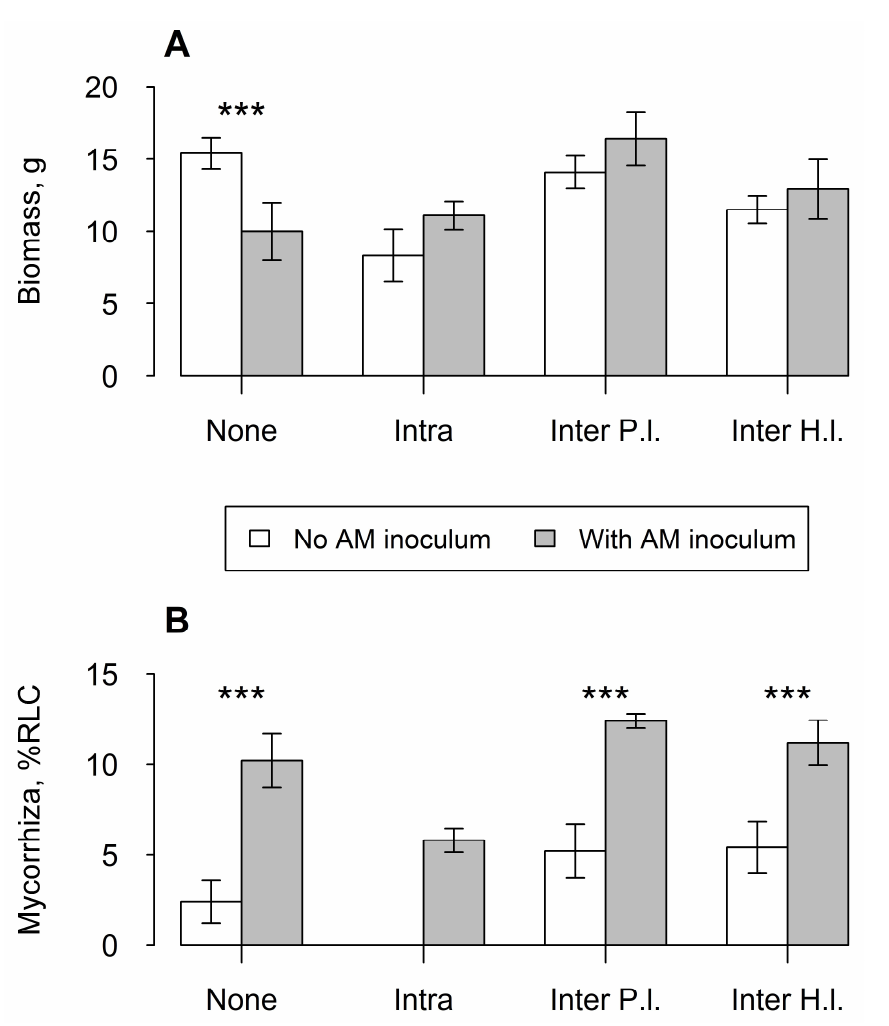
Figure 1. Mean of ( A ) dry shoot biomass and ( B ) AM fungal colonisation of Impatiens glandulifera across treatments. ‘None’ indicates a single balsam with no competition as a control. ‘Intra’ was intraspecific competition while ‘Inter P.l.’ and ‘Inter H.l.’ were interspecific competition with Plantago lanceolata and Holcus lanatus , respectively. %RLC: Percentage of root length colonised. Vertical bars represent ± one standard error. Asterisks above bars indicate significance of difference between means, ***: p < 0.001.